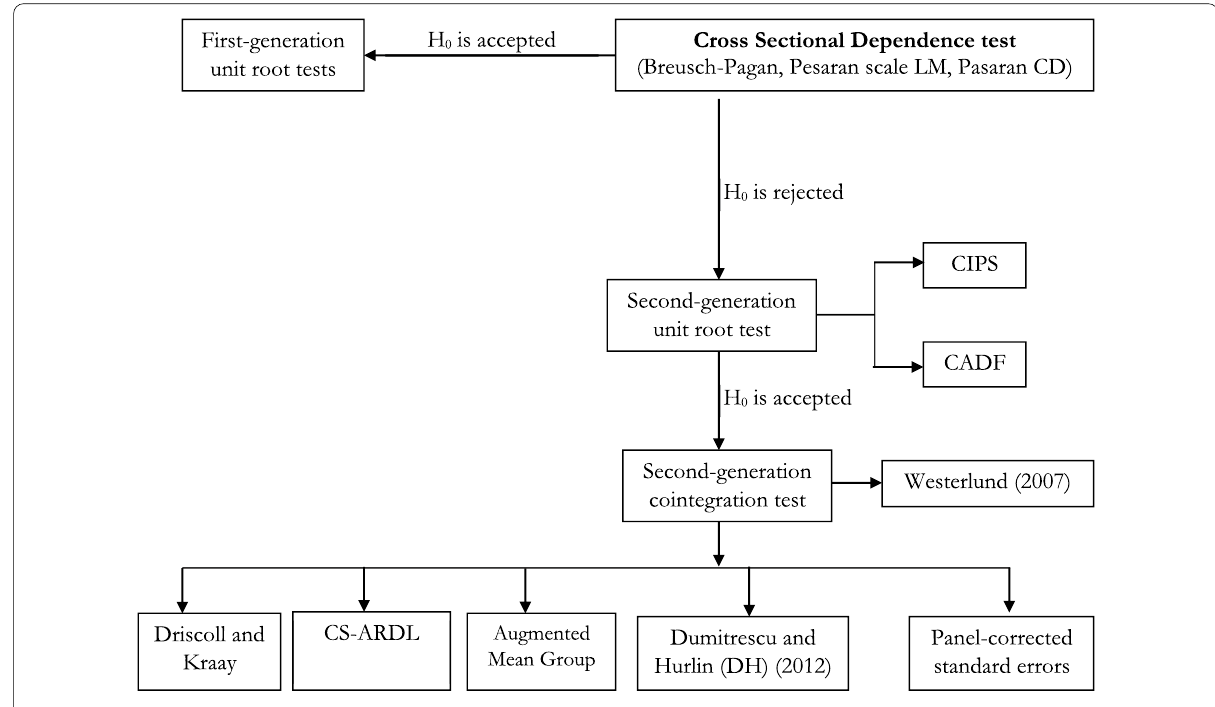
Fig. 2 Methodological schema of the